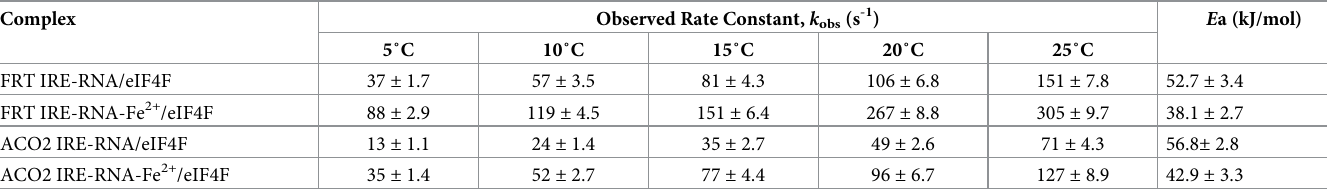
ACO2 IRE-RNA-Fe 2+